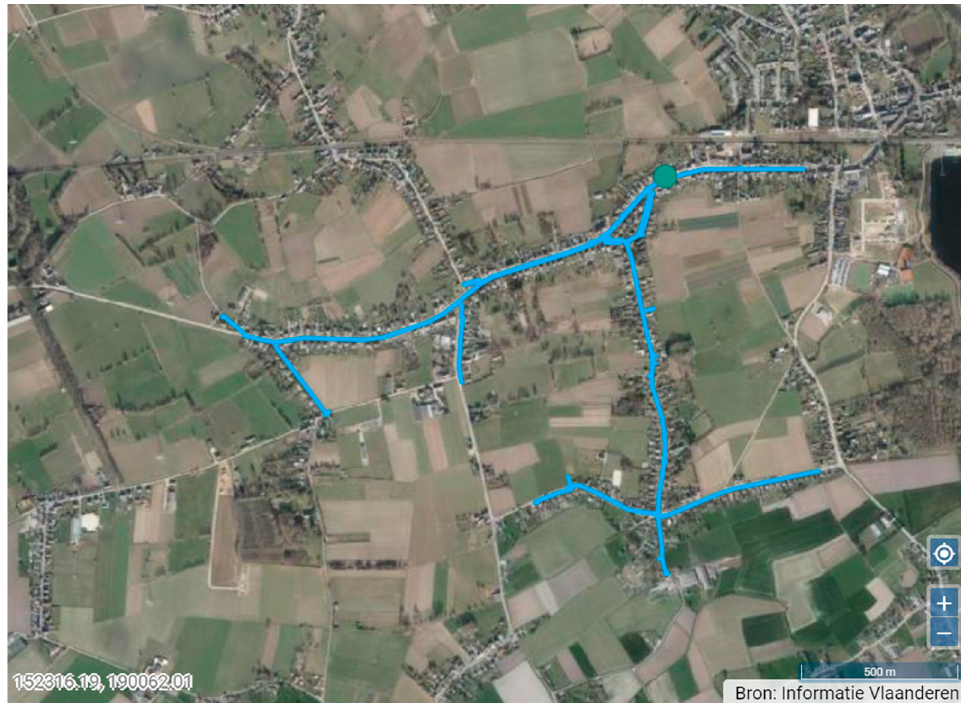
Figure A4. Overview of the catchment in Mechelen. The green dot shows the inspection well where the samples were taken. The blue area is connected to this inspection well.